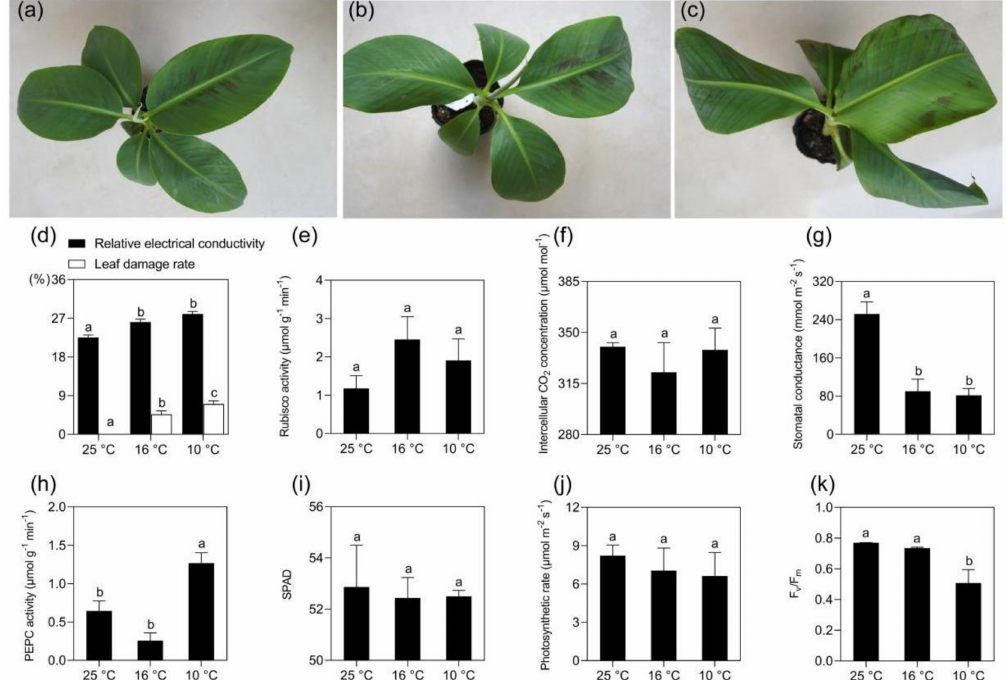
Figure 1. The symptoms and changes in physiological parameters of Musa spp. AAA cv. Baxijiao upon chilling stress. ( a – c ) Banana plants incubated at 25 ◦ C, 16 ◦ C or 10 ◦ C for 2 days; ( d – k ) Determination of the physiological parameters in the Musa spp. AAA cv. Baxijiao at 25 ◦ C, 16 ◦ C, and 10 ◦ C. Data represent an average of three replicates ± standard error. Di ff erent letters above the columns represent significant di ff erence using Duncan’s multiple range test at p < 0.05 after angular transformation of the